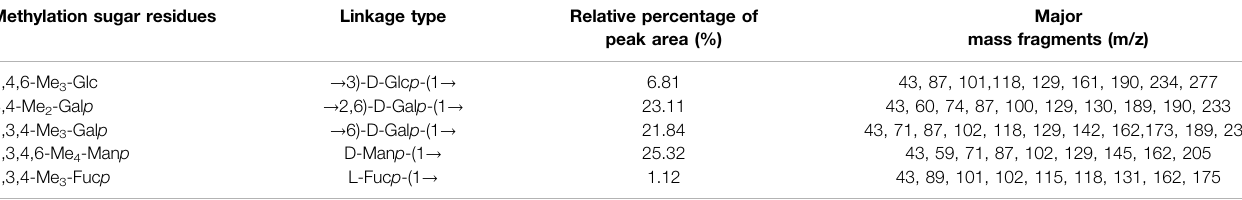
TABLE 1 | Linkage patterns of PPp-W from P. placentodes identi fi ed by methylation and GC – MS analysis. Methylation sugar residues Linkage type Relative percentage of